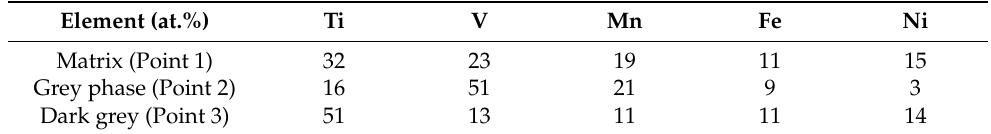
Table 2. Table 2. EDX analysis showing the elemental composition of all the phases of as-cast